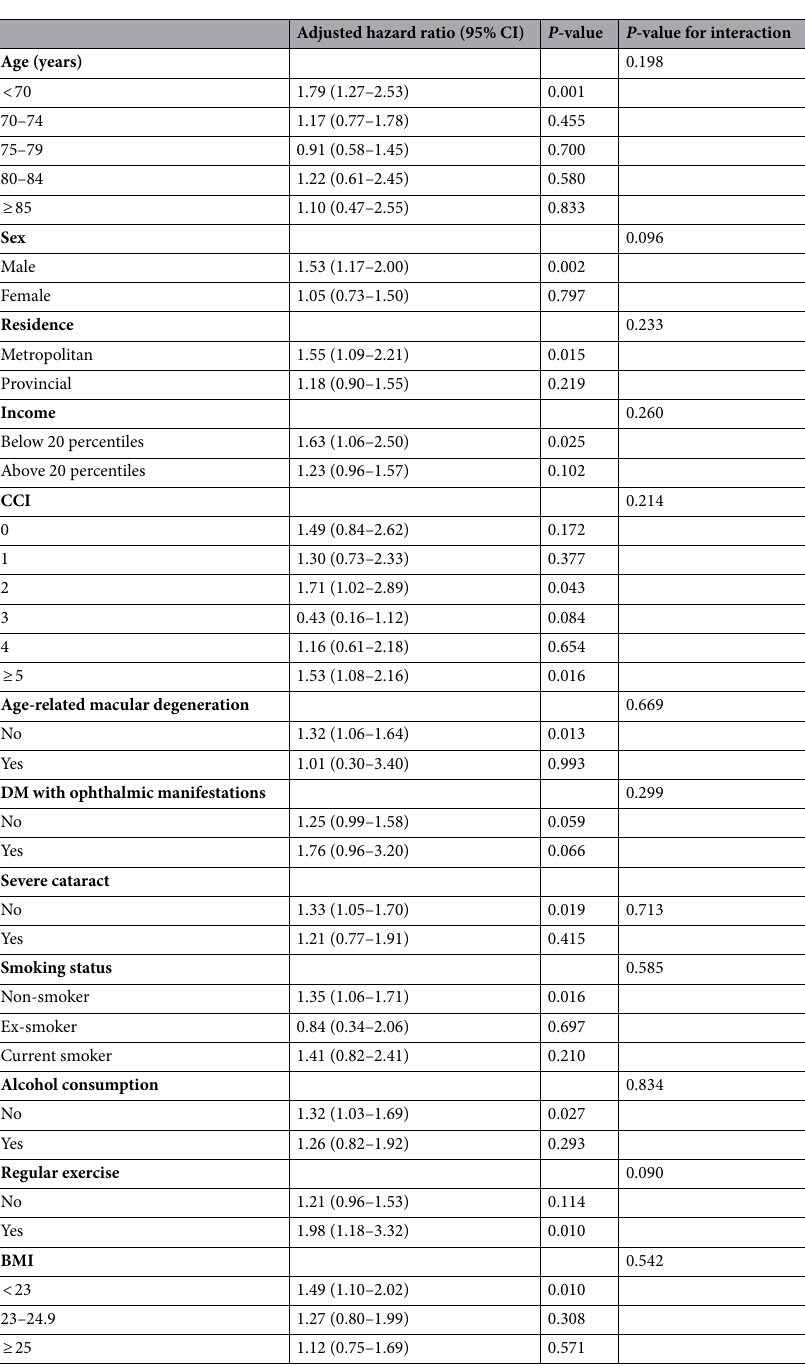
Table 4. Hazard ratios of mortality in Korean elderly patients with glaucoma according to age, sex, residence, income, Charlson comorbidity index score, and ocular comorbidities. Glaucoma diagnosis group was used as a reference in all models. Adjusted for age, sex, income, region, Charlson Comorbidity Index score (0, 1, 2, 3, 4, and ≥ 5), age-related macular degeneration, DM with ophthalmic manifestations, cataract severity, smoking, drinking, exercise, and BMI. BMI body mass index, CCI Charlson Comorbidity Index, DM diabetes